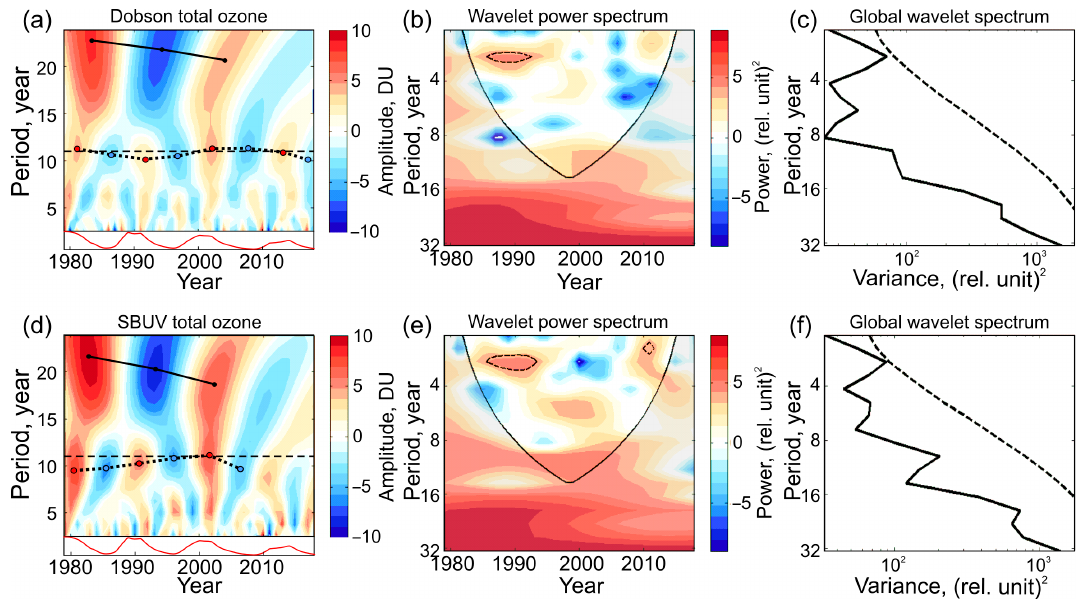
Figure 5. As in Figure 4, but for total ozone over Faraday / Vernadsky in 1979–2018 from ( a – c ) Dobson spectrophotometer measurements and ( d – f ) SBUV data. Red curve at the bottom in ( a ) and ( d ) is the smoothed time series of the sunspot number from Figure 3 (red curve).